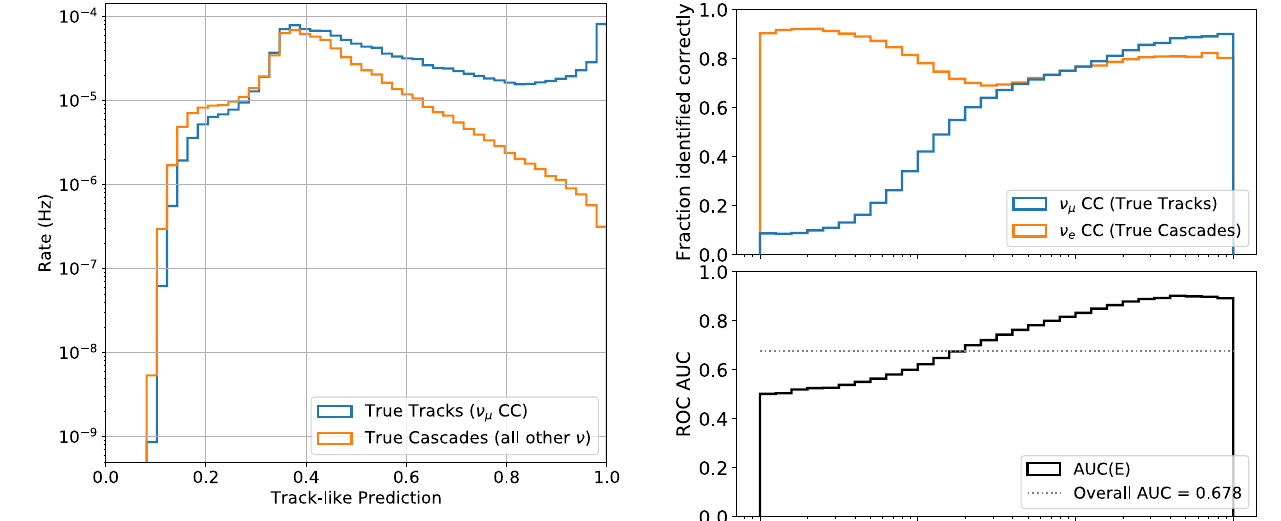
Fig. 14 Distribution of classification scores for events that are tracks (blue) and cascades (orange)